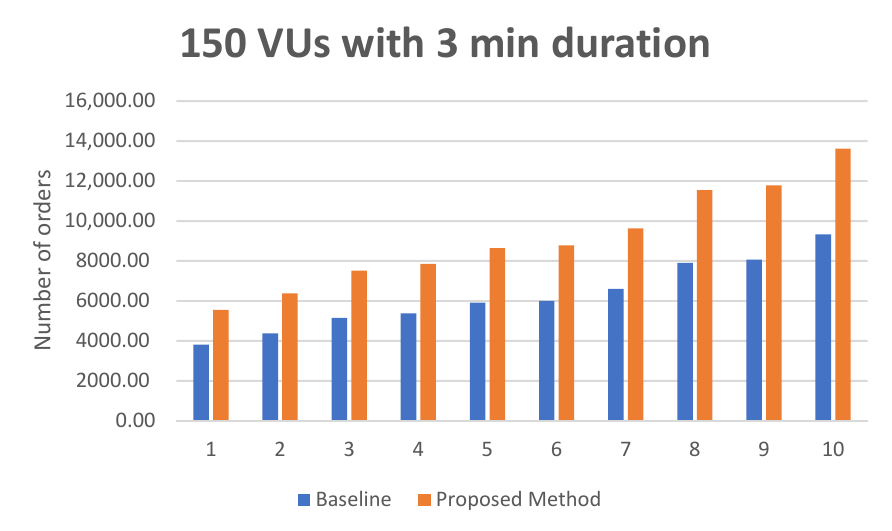
Figure 23. Load Testing—100 virtual users with 3 min duration.